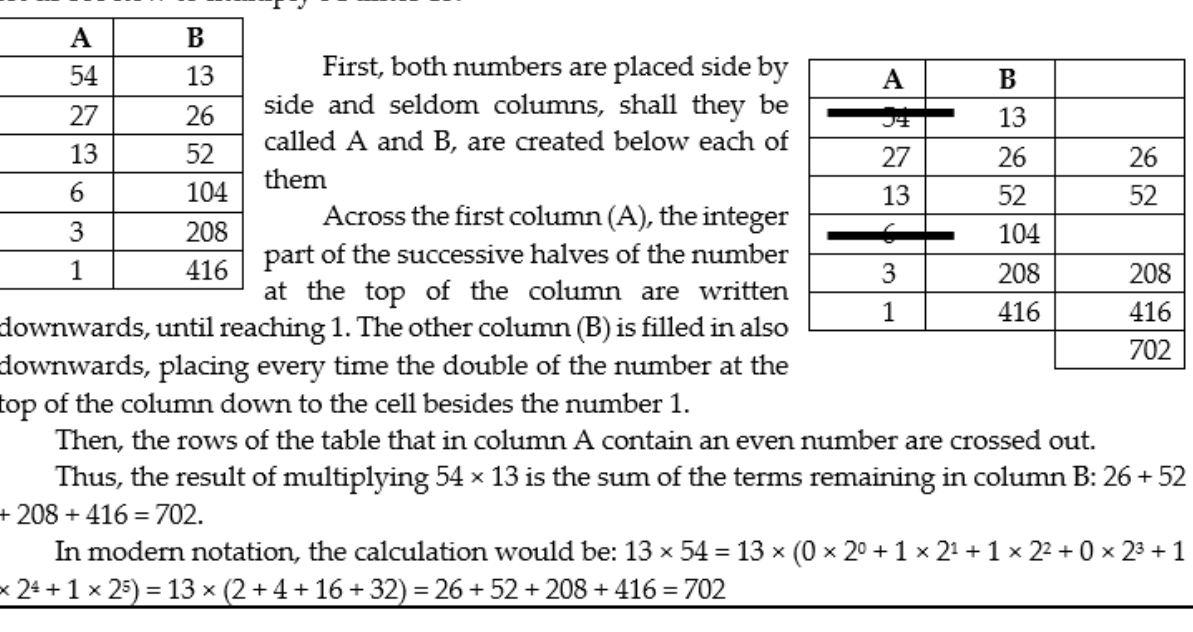
Figure 1. Description of the Egyptian multiplication method as presented to the students.